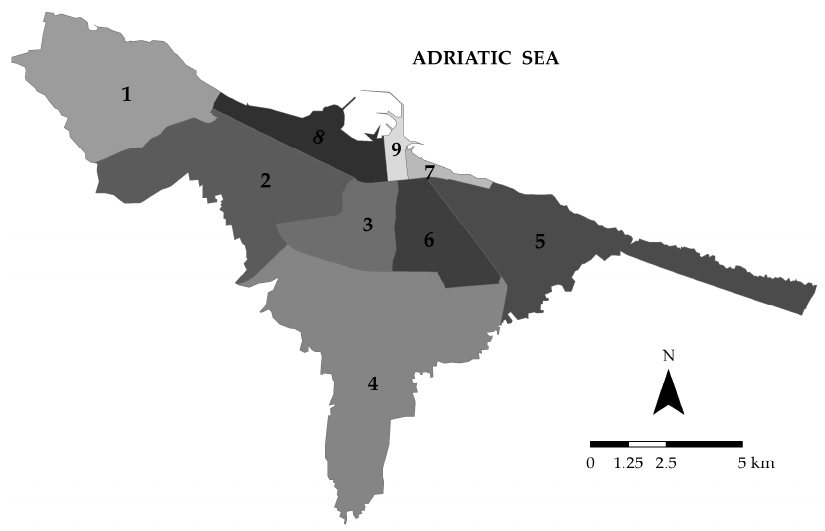
Figure 3. Lost ornamental value in the City of Bari for the infections of RPW to Canary Palms. The shades of grey concern the average ornamental values between the two methods, and from the Monte Carlo analysis (Numbers on the map refer to the urban districts).